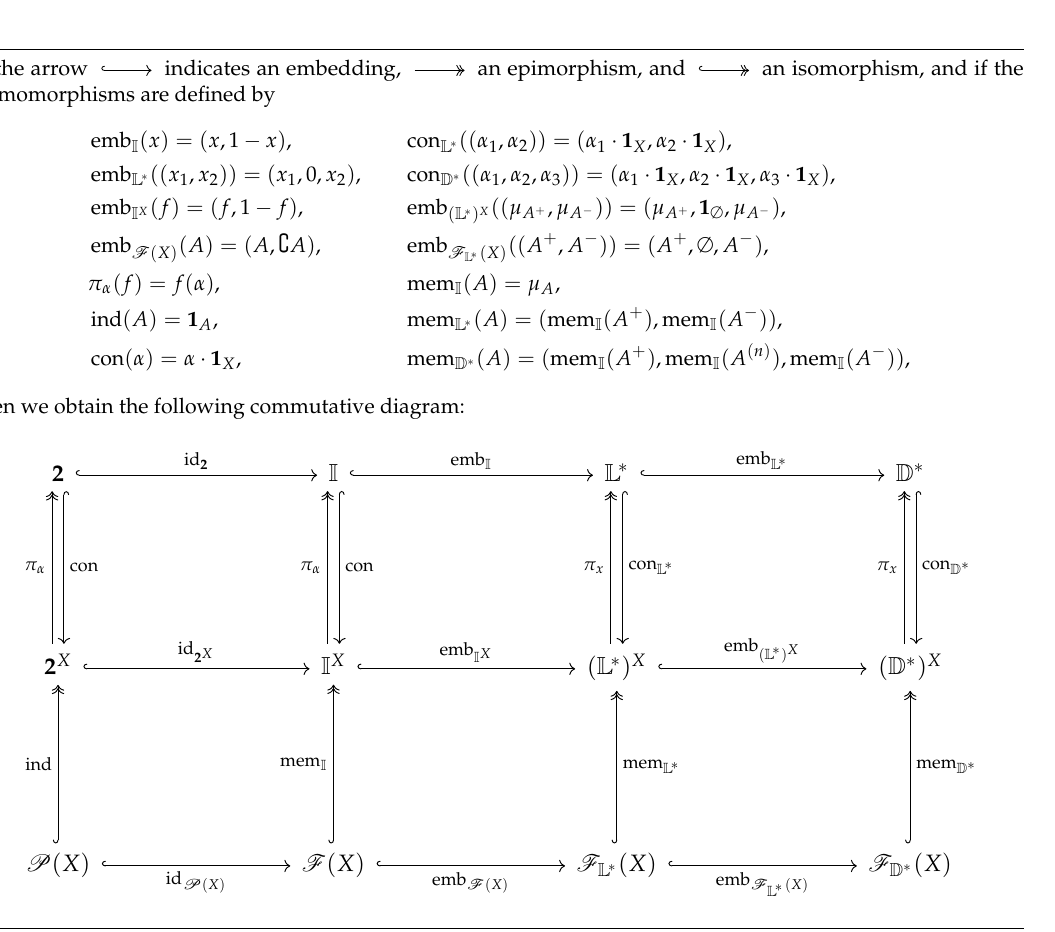
Figure 3. Crisp sets, fuzzy sets, L ∗ -fuzzy sets, and picture fuzzy sets, and the corresponding sets of truth values.